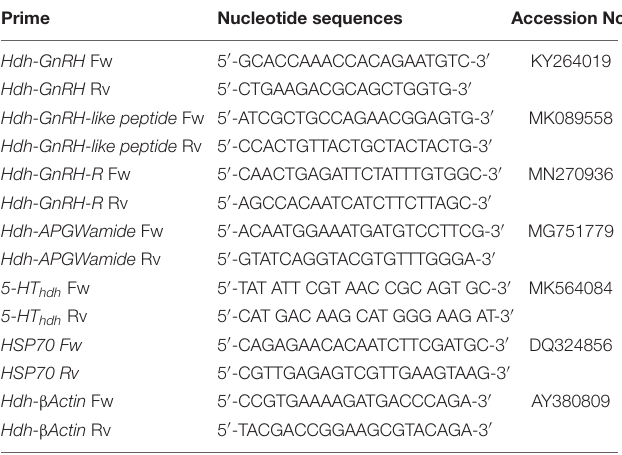
TABLE 1 | Primers used in quantitative real-time PCR (qRT-PCR). Prime Nucleotide